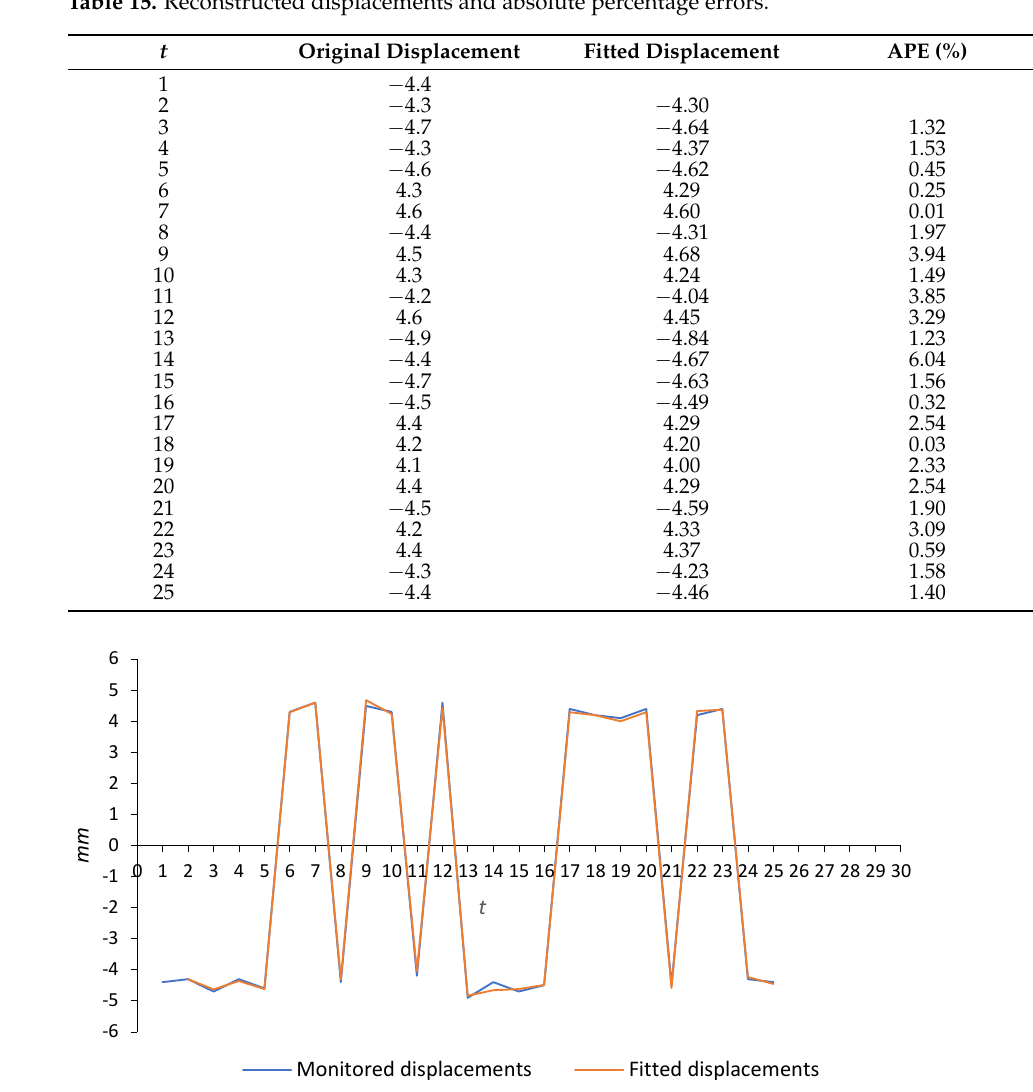
Table 15. Reconstructed displacements and absolute percentage errors.